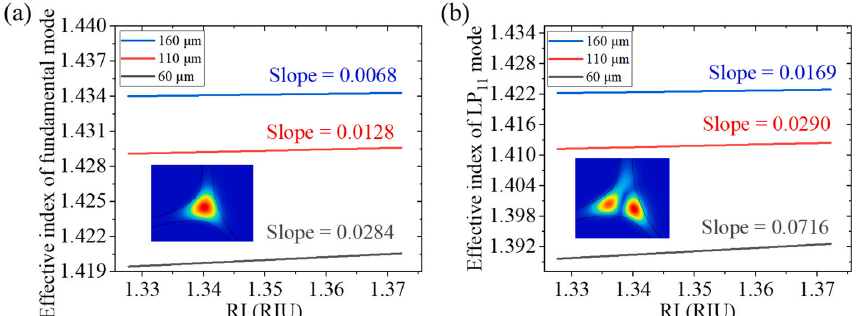
Figure 1. The relationship between external RI and the resulting change in effective mode index under different diameters: ( a ) fundamental mode; ( b ) high-order mode [40]. Reprinted with permission from Ref. [40], Copyright 2022 Elsvier Science and Technology Journals. .